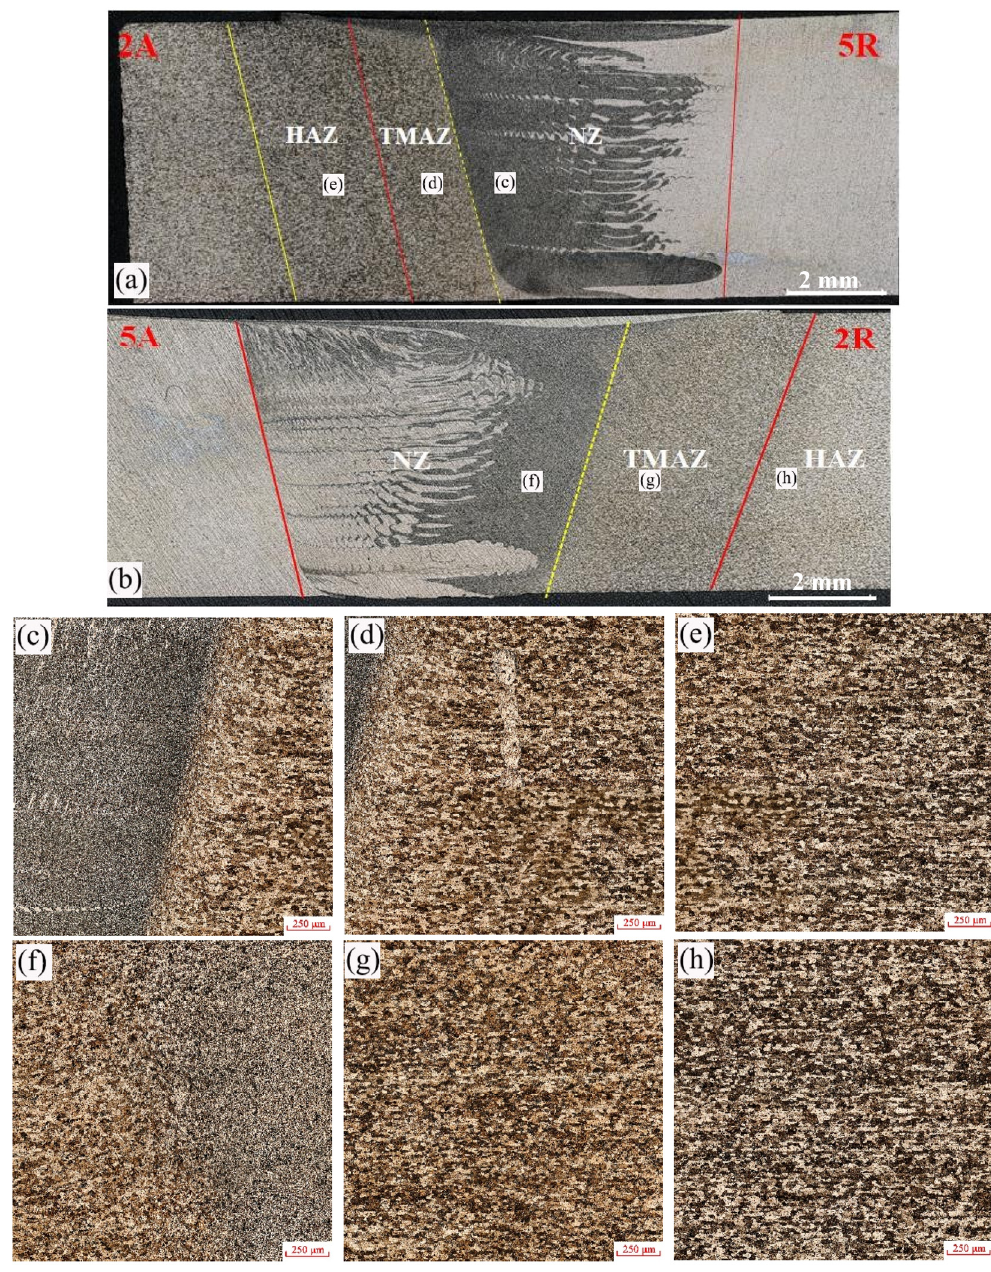
Figure 3. Micromorphology taken at different locations of welded joints (rotational speed of 800 rpm and welding speed of 100 mm/min). ( a ) 2A5R-joint, ( b ) 5A2R-joint, ( c – h ) correspond to the position in ( a , b ).